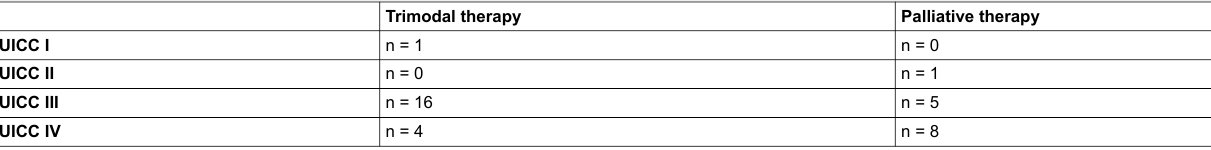
Table 3: Postoperative minor and major complications of patients after EPP (n = 21).